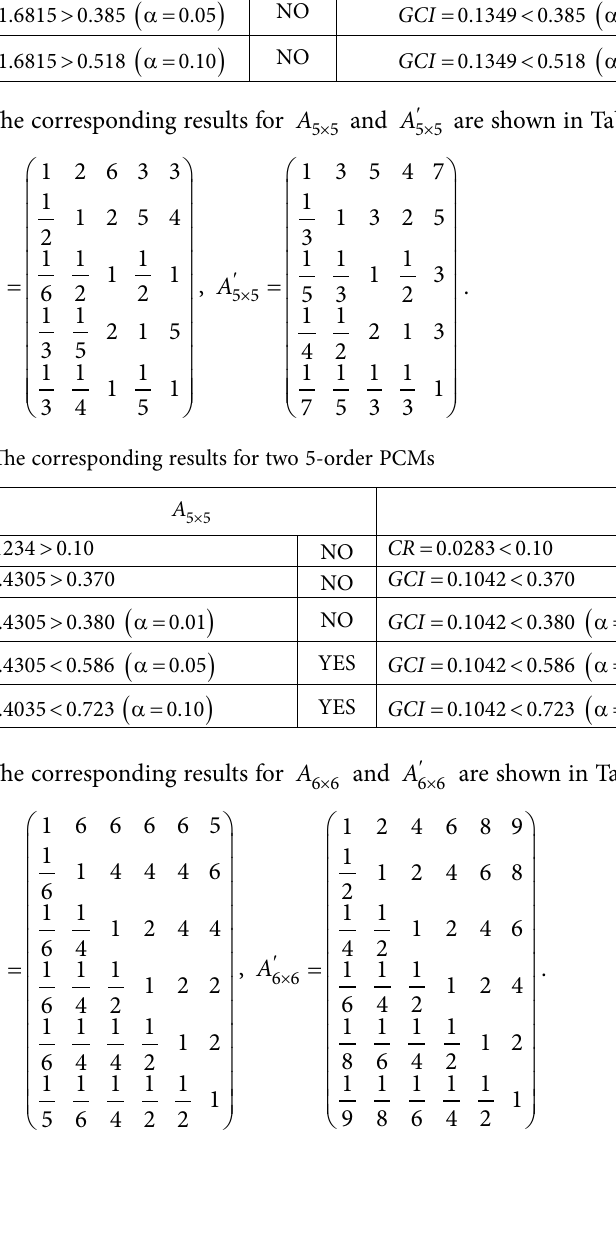
Table 5. The corresponding results for two 4-order PCMs × 4 4 A = > 0.5513 0.08 CR NO = < 0.0383 0.08 CR YES = > 1.6815 0.3526 GCI < 0.1349 0.3526 GCI = > 1.6815 0.205 GCI